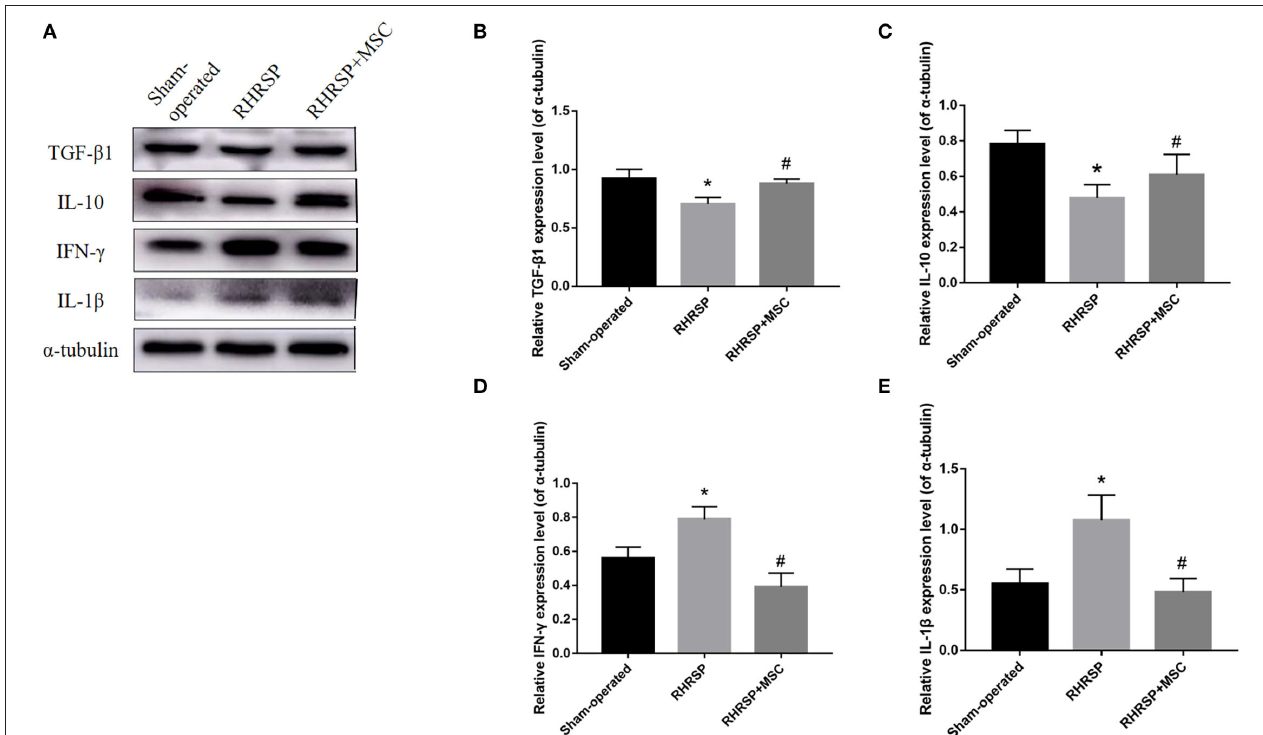
FIGURE 9 | Effects of MSCs treatment on the expression of cytokines in the hippocampus. (A) Representative images of western blot analysis of TGF- β 1, IL-10, IFN- γ , IL-1 β and α -tubulin in the hippocampus in three groups. (B–E) Quantification of the relative protein expression levels of TGF- β 1, IL-10, IFN- γ , IL-1 β . (*P < 0.05, vs. sham-operated group, #P < 0.05, vs. RHRSP group; n =